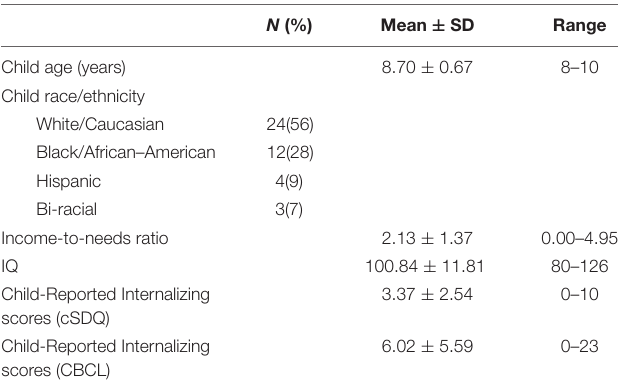
TABLE 1 | Characteristics of the participants.